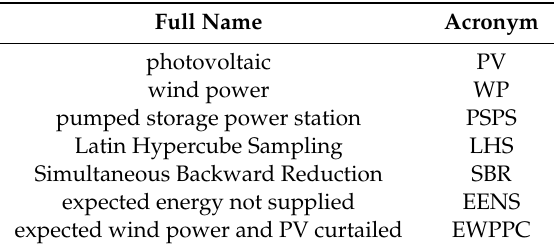
Table A2. Table of full names and